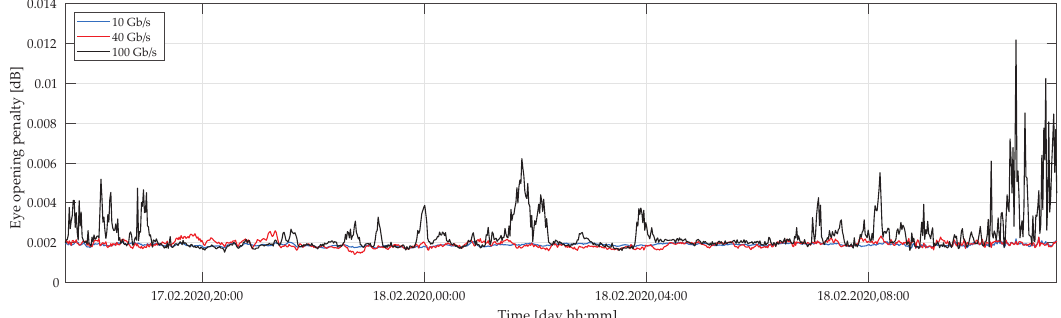
Figure 11. Calculated eye opening penalty as a function of time under weak wind conditions for several transmission bit rates of 10, 40, and 100